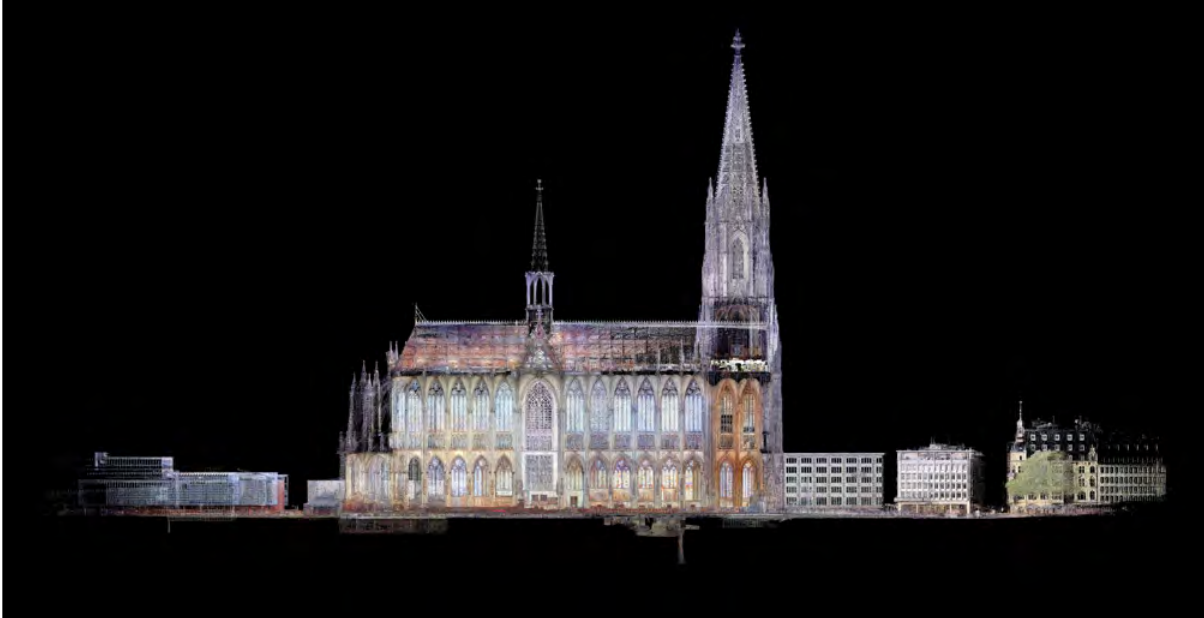
Image 8: Cross-section point cloud rendering through the Cathedral and precinct. Note the foundation tunnel at the base of the